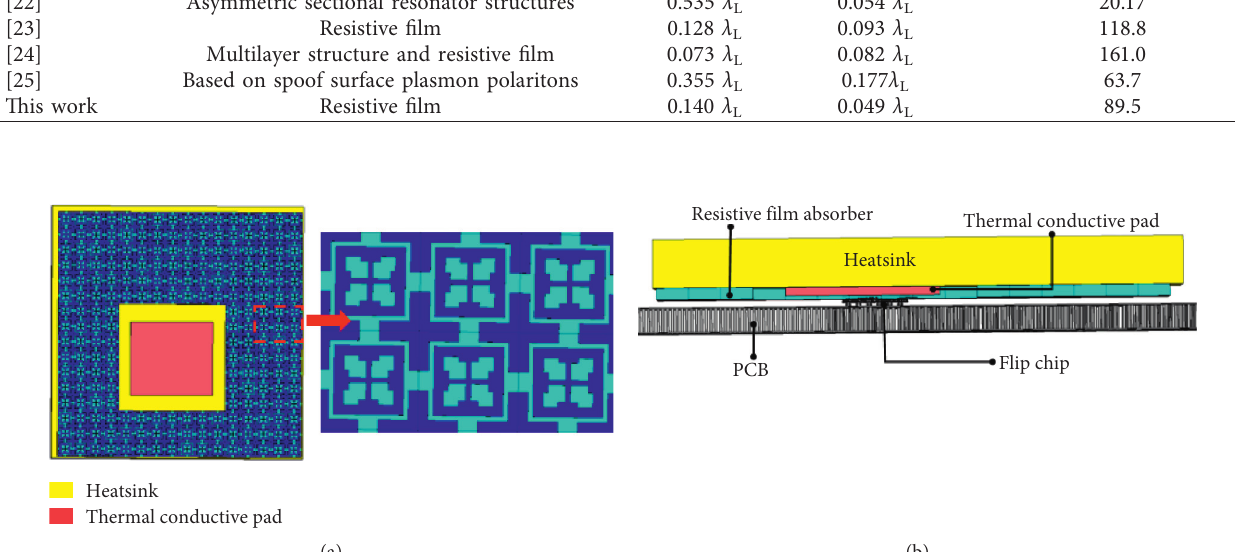
Figure 24: (a) The arrangement of periodic structure of resistive film absorber on the heatsink and (b) cross-sectional view of heatsink with the proposed